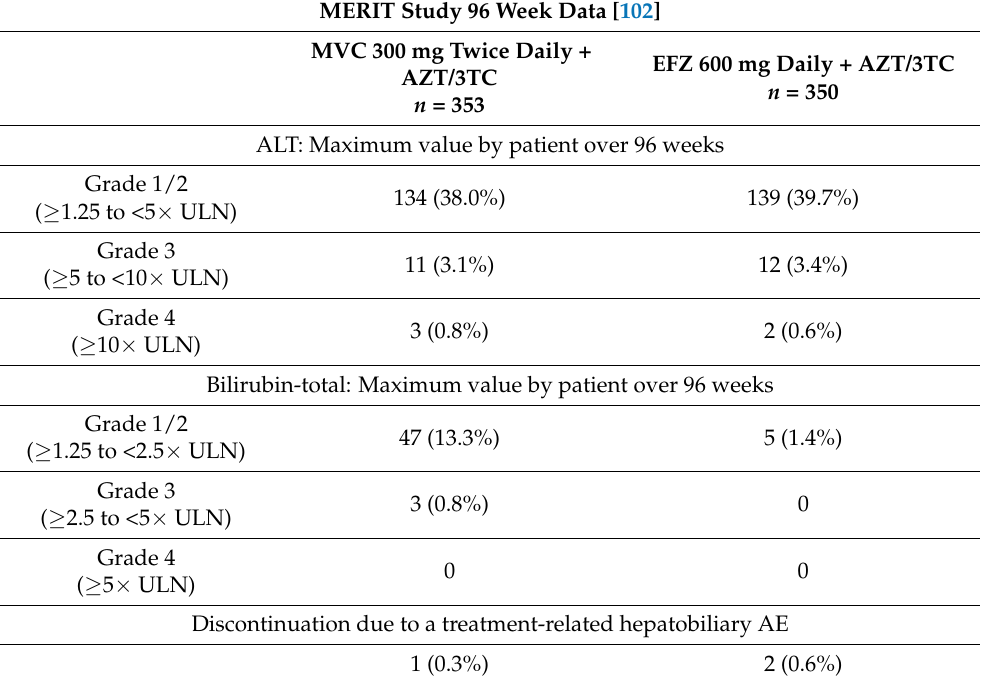
Table 7. ALT/Bilirubin and hepatobiliary discontinuation related to maraviroc in